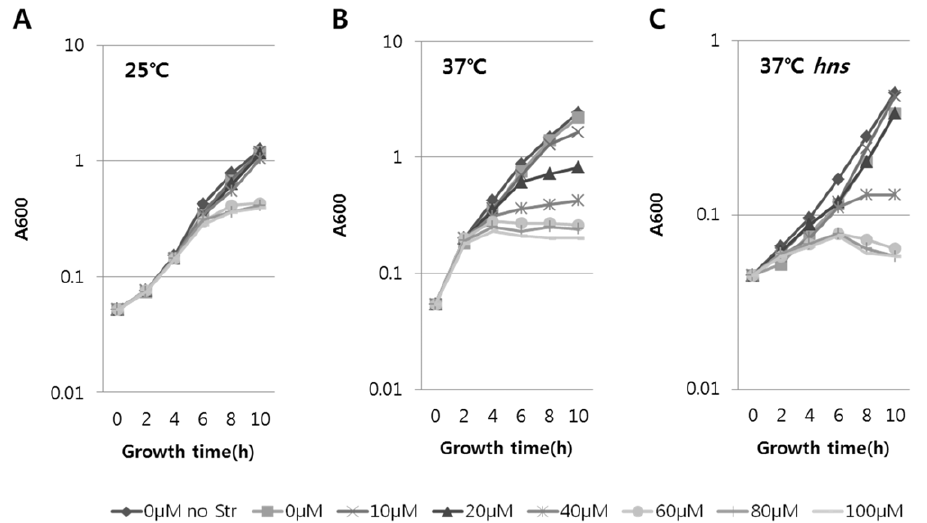
Figure 8. Invivo measurement of the antagonistic effect of CnuK9E on DicA binding to Oc. The DNA binding activity of DicA to Oc was measured with different concentrations of IPTG, resulting in different concentrations of CnuK9E. Growth of HL100/pHL1191/pCnuK9E was measured at 25 u C (A) and 37 u C (B). The antagonizing effect of CnuK9E was also measured in HL100 g hns /pHL1191/pCnuK9E (C) where H-NS is absent. The symbol for each IPTG concentration is presented below the graphs.